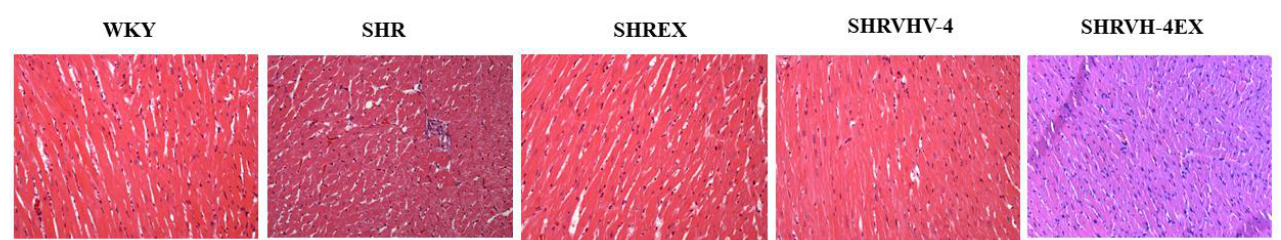
Figure 2. Effect of VH-4 and exercise on heart histology of control and treatment groups. H&E staining. Magnification 100×.